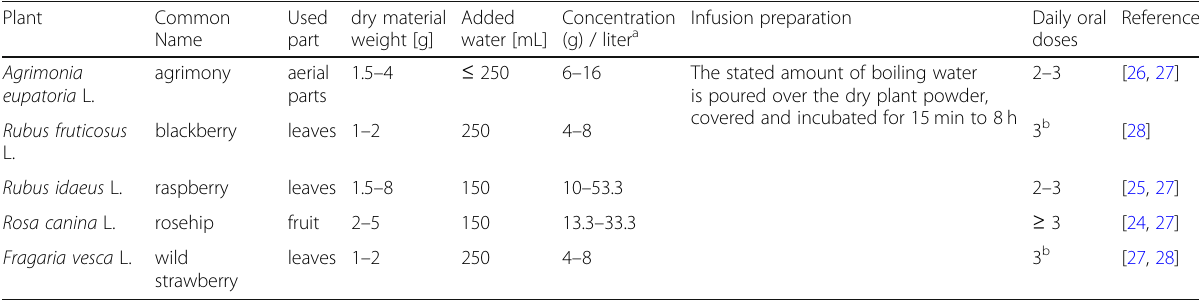
Table 2 Traditional preparation of plant infusions for the treatment of diarrhea in Poland Plant